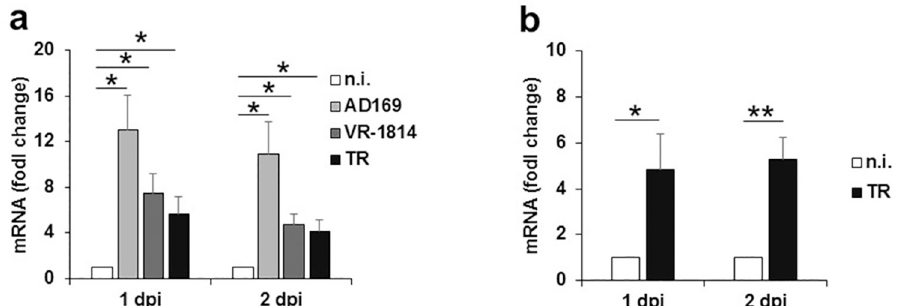
Fig 1. Upregulation of SAMHD1 mRNA in HCMV-infected cells. Primary human foreskin fibroblasts (HFFs) (panel a) or PMA-differentiated THP-1 cells (panel b) were infected with the indicated HCMV strains at an MOI of 1, or not infected (n.i.). At the indicated times after infection, real-time PCR was performed using primers specific for SAMHD1, or for the housekeeping gene GAPDH. Data from three (a) or two (b) independent experiments, expressed as fold change units ± SE, were normalized with GAPDH and referred to n.i. cells considered as calibrators and set ad 1. dpi, day post-infection; � , p < 0.05; �� , p < 0.01.